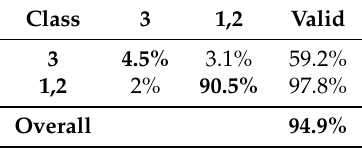
Table 9. Results from the test part of the dataset from the CNN for vehicle binary classification. Final results for each class on the main diagonal in confusion matrix (highlighted as bold) are shown.